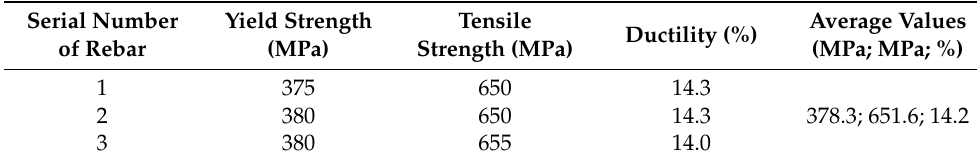
Table 6. Results of the 55#/316L rebar tensile experiment.